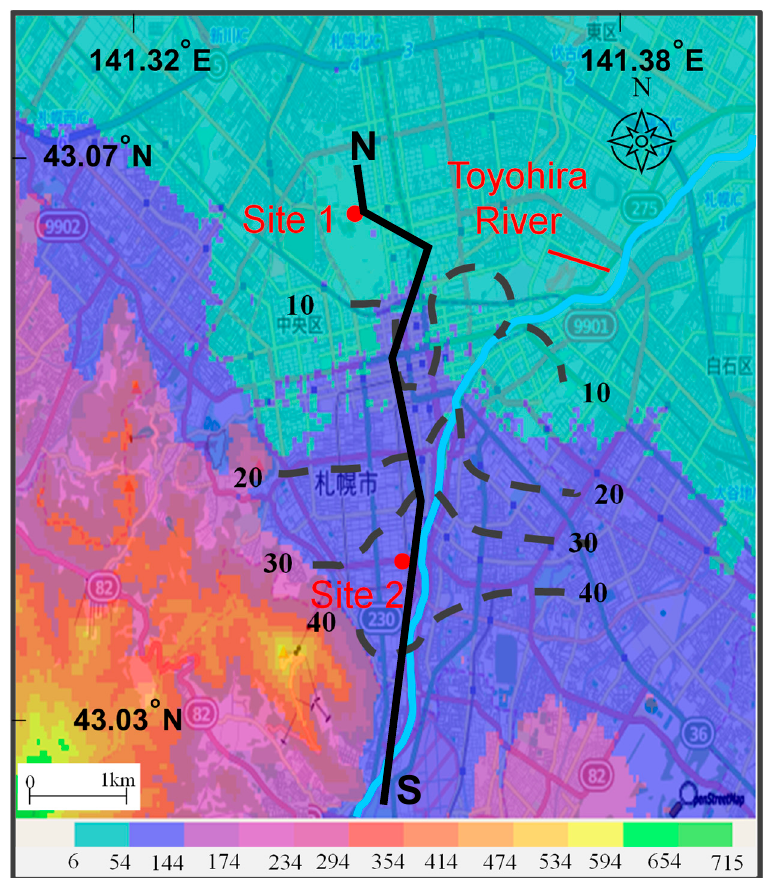
Figure 2. Site location for field experiments on a ground-elevation map (© OpenStreetMap contributors) [12]. The edge of blue areas denotes the topographic boundary of an alluvial fan of Toyohira River. Dashed lines denote groundwater-table elevation contours from 10 to 40 m above mean sea level (m. amsl), modified from [13]. The black bold line is for a geologic cross-section in Figure 3.